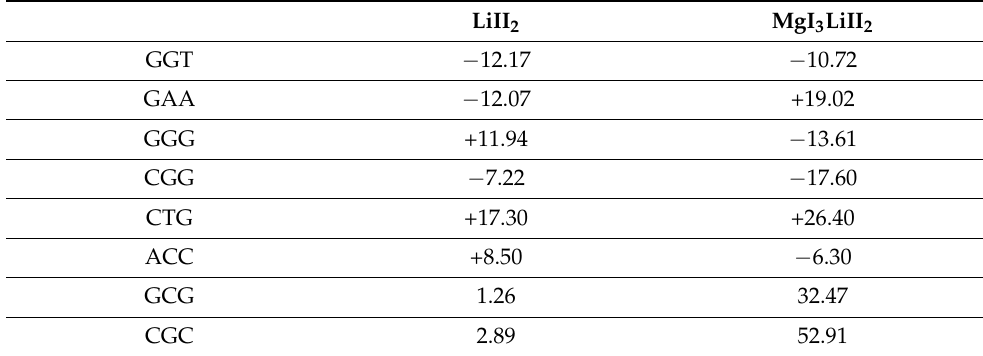
Table 4. Interaction energies (kcal/mol) of nucleotide triplets with active centers of the FS-1 drug.